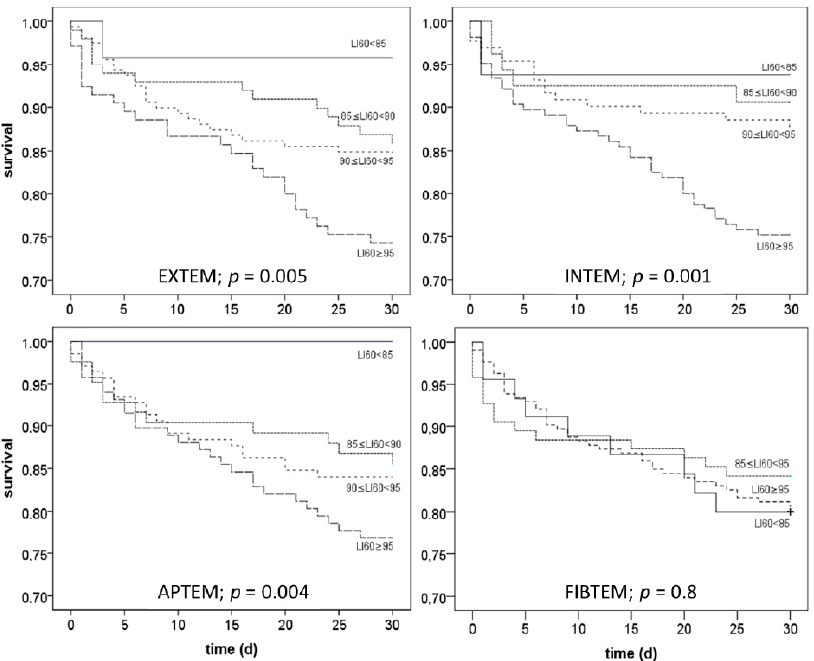
Figure 3. Effect of the clot lysis indices obtained with 4 different ROTEM™ assays before the start of the liver transplantation procedure on 30-day mortality. Shown are calculations resulting from univariate binary logistic regression analyses and the corresponding significance levels.